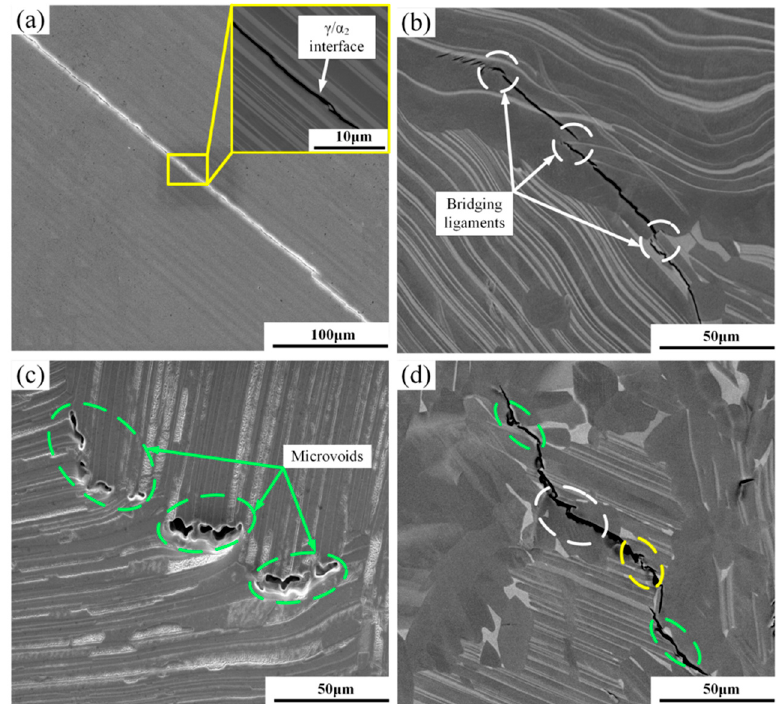
Figure 9. Cracking modes of the hydrogenated alloy deformed at 1150 °C/0.001 s − 1 : ( a ) inter-lamellar crack, ( b ) trans-lamellar crack, ( c ) along-lamellar colony boundary crack, and ( d ) mixed mode crack.